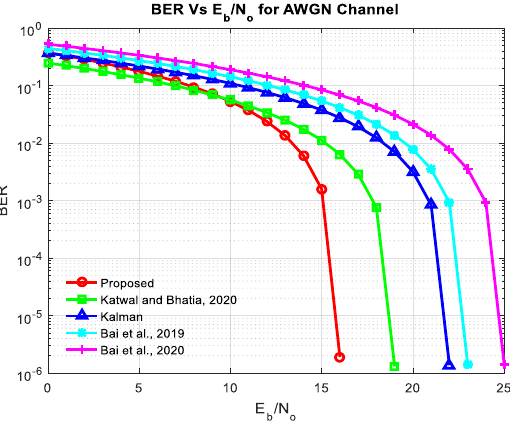
Figure 6. BER vs E